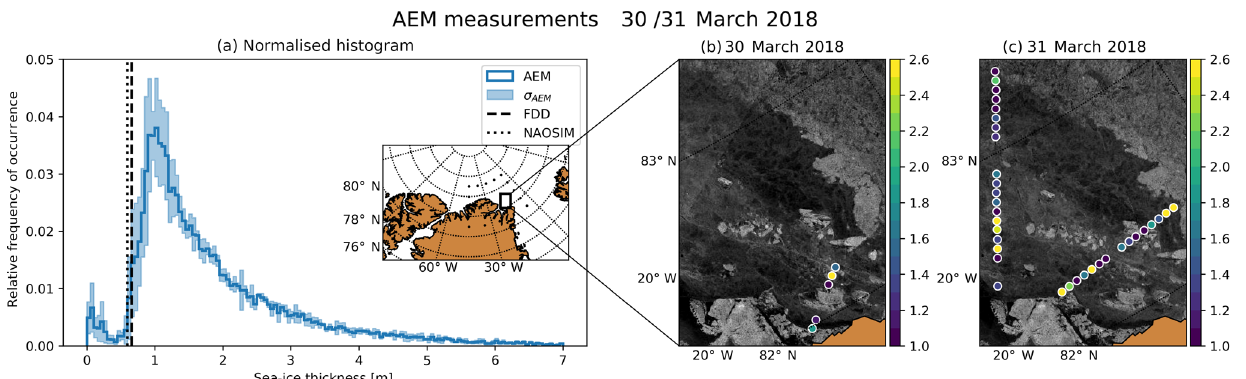
Figure 11. AEM measurements of the thickness of young first-year ice formed in the polynya until the end of March. (a) Normalised histogram of the AEM measurements. The shades indicate the standard deviation of the three single flights. The black vertical line shows the mean sea-ice thickness calculated based on freezing degree days since 14 February. The dotted polygon shows the region of the polynya. The small black rectangle shows the region of the AEM flights. (b, c) AEM flights on 30 and 31 March. The dots show the AEM measurements, averaged every 5km. The background shows a Sentinel-1 mosaic for the respective day.